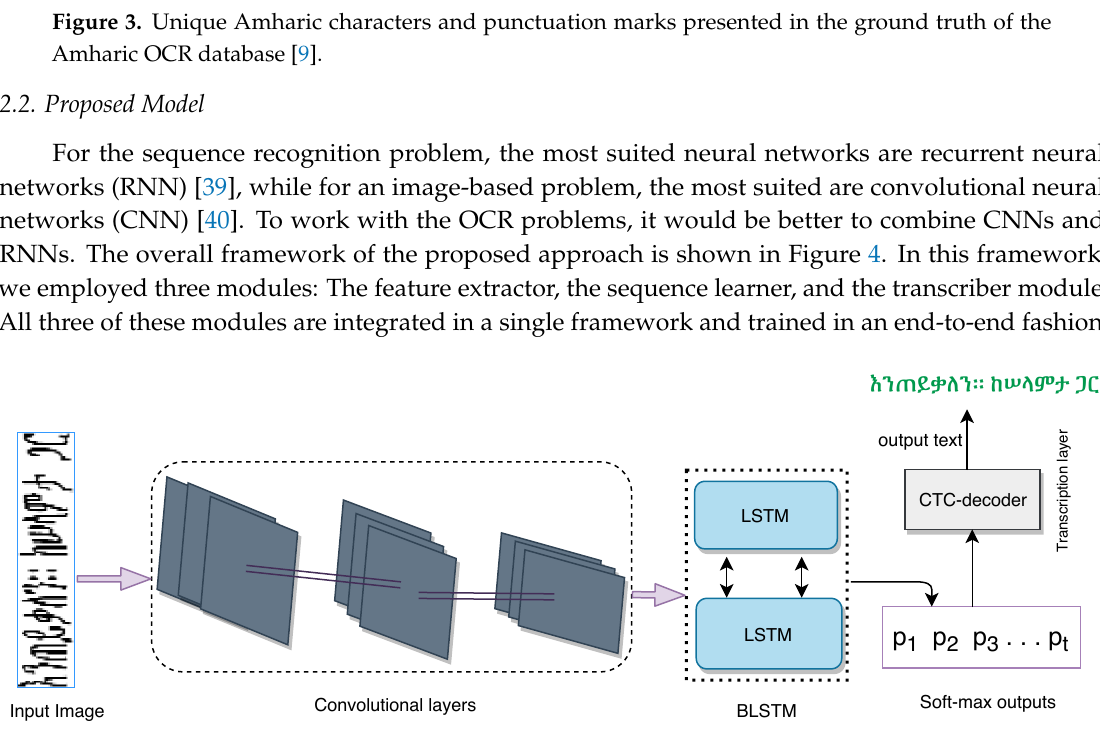
Figure 4. The proposed model. This network consists of three components. The first component is the convolutional layer which acts as the feature extractor, the second component is the recurrent layer which acts as a sequence learner, plus a soft-max function to predict a label distribution at each time-step. The third component is a Connectionist Temporal Classification (CTC) layer which takes the soft-max prediction at each time-step as an input and transcribes these predictions into final label sequences. All input text-line images are normalized to a fixed size of 32 by 128 pixels, and labels are padded with zero until they reach the maximum sequence length of